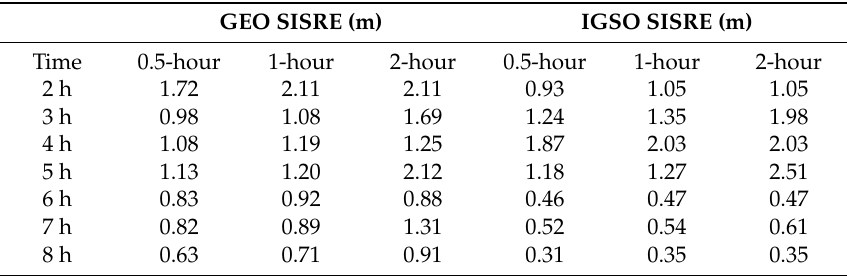
Table 7. Average orbit-only SISREs of the recovered GEO and IGSO with different update intervals. GEO SISRE (m) IGSO SISRE (m) Time